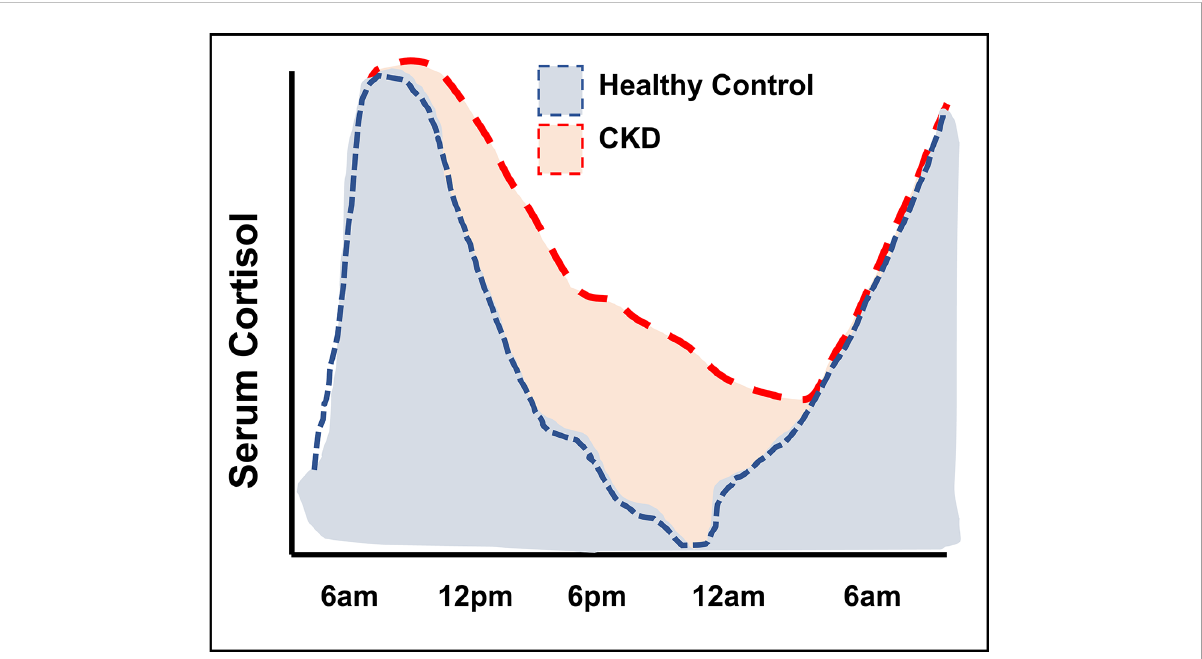
FIGURE 3 Illustration of diurnal cortisol levels in people with kidney failure compared to healthy control groups. Figure adapted from Raff et al. (32) and Deshmukh et al.